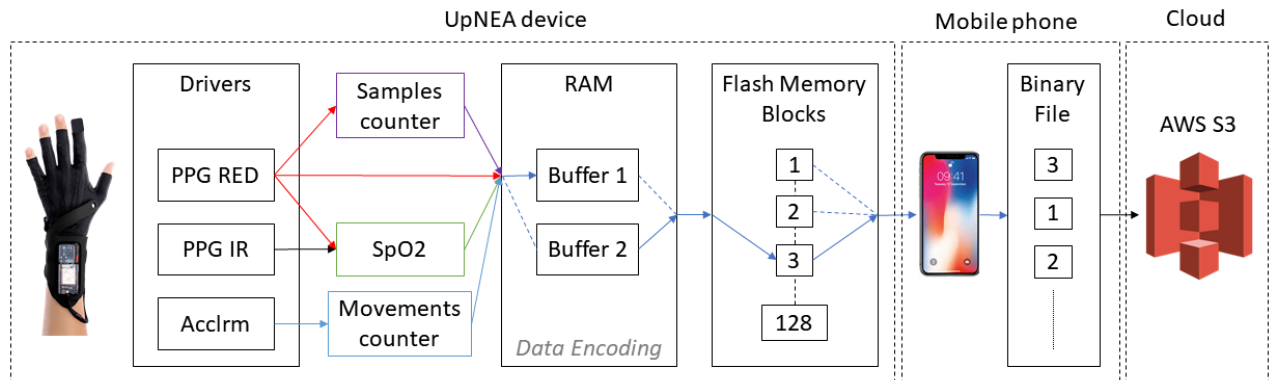
Figure 2. Datastream visualization for